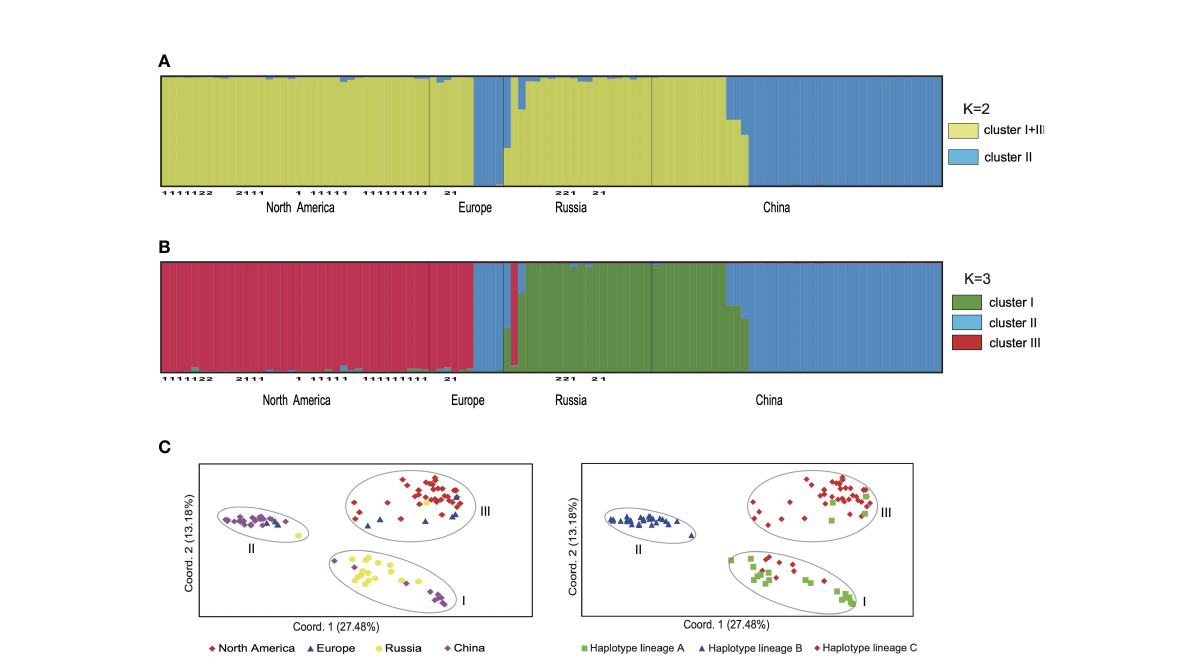
FIGURE 3 The genetic clusters of Hippuris vulgaris based on nuclear microsatellite data. (A) The bar plot depicts the STRUCTURE admixture coef fi cients for individuals when K = 2. Samples of H. lanceolata and H. tetraphylla were marked with the number 1 and 2, respectively. (B) The bar plot depicts the STRUCTURE admixture coef fi cients for individuals when K = 3. Samples of H. lanceolata and H. tetraphylla were marked with the number 1 and 2, respectively. (C) Principal coordinate analysis performed from pairwise genetic distances among individuals. Individuals were